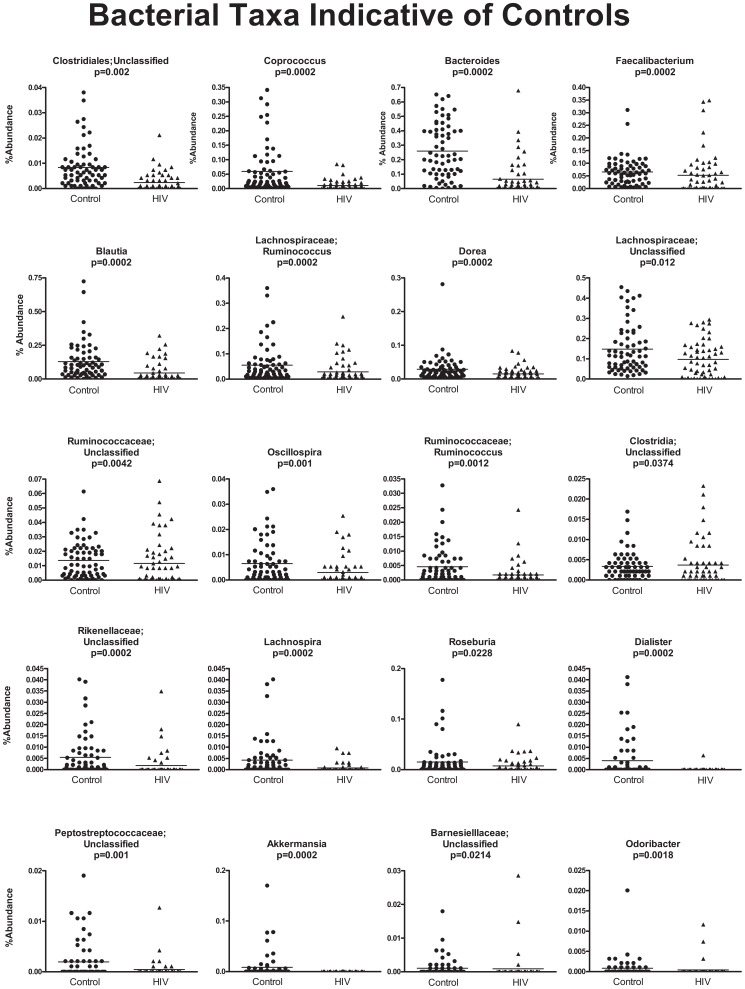
Scatterplots of bacterial taxa indicative of control samples.Y-axis shows percent abundance in rarified sequences for each sample. Control samples are shown as black dots and HIV samples are shown as upward black triangles. Horizontal lines denote mean value in each group. P-values shown are results from indicator species analysis. Genera and those unclassified bacterial members of families that not able to be classified down to a particular genus, that also have indicator values >15 and p<0.05 are shown.